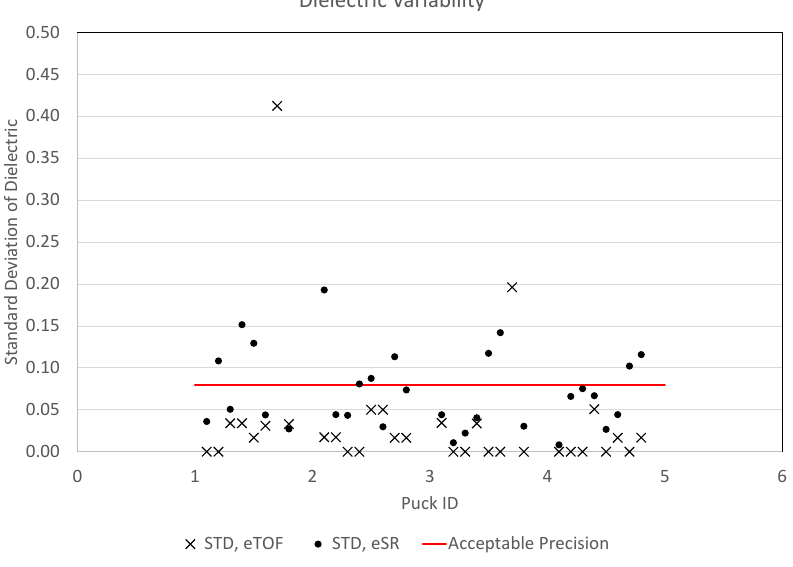
Figure 16. SR and time-of-flight (TOF) dielectric standard deviation versus asphalt specimen ID for all 38 evaluated asphalt specimens, where the ID is .